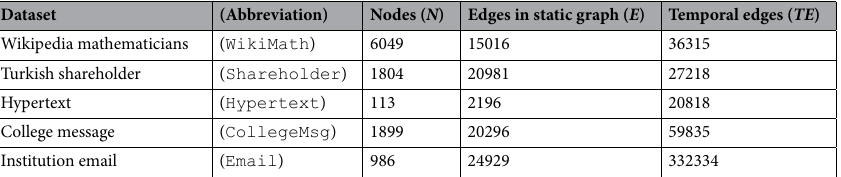
Table 1. Summary of network statistics. Edges in static graph gives the number of node pairs that have at least one interaction while the Temporal Edges gives the total number of interactions between edge pairs, so some edge pairs have more than one temporal